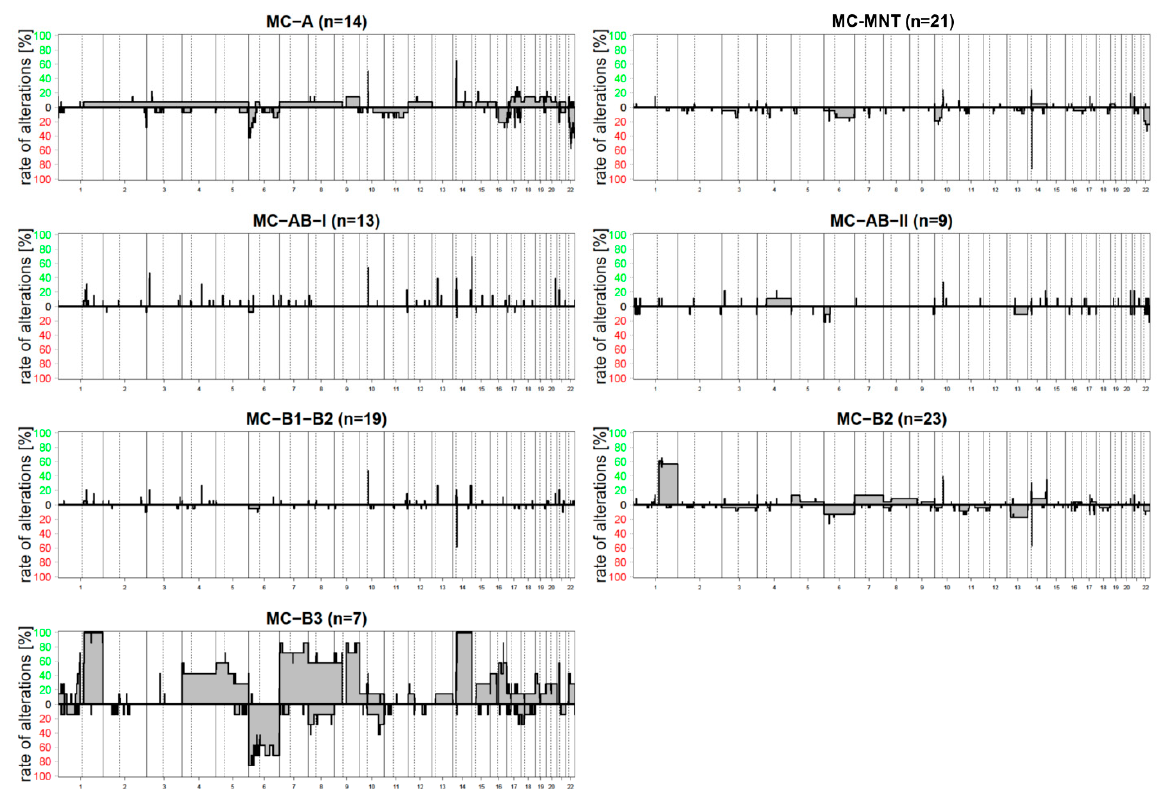
Figure 6. Frequency plots of genomic copy number aberrations (CNAs) in the methylation cluster (MC)-based thymoma subgroups. CNAs are rare in MC-A, MC-MNT, MC-AB-I, MC-AB-II, and MC-B1-B2, but enriched in MC-B2 and MC-B3 thymomas. If present, most CNAs are large-scale, chromosome arm level CNAs. Gains of chromosomal material are most common for chromosome arm 1q in MC-B2, accompanied by 4, 5, 7, 8, 9, 14, and 16 in MC-B3. Deletions most frequently involve chromosome 6.